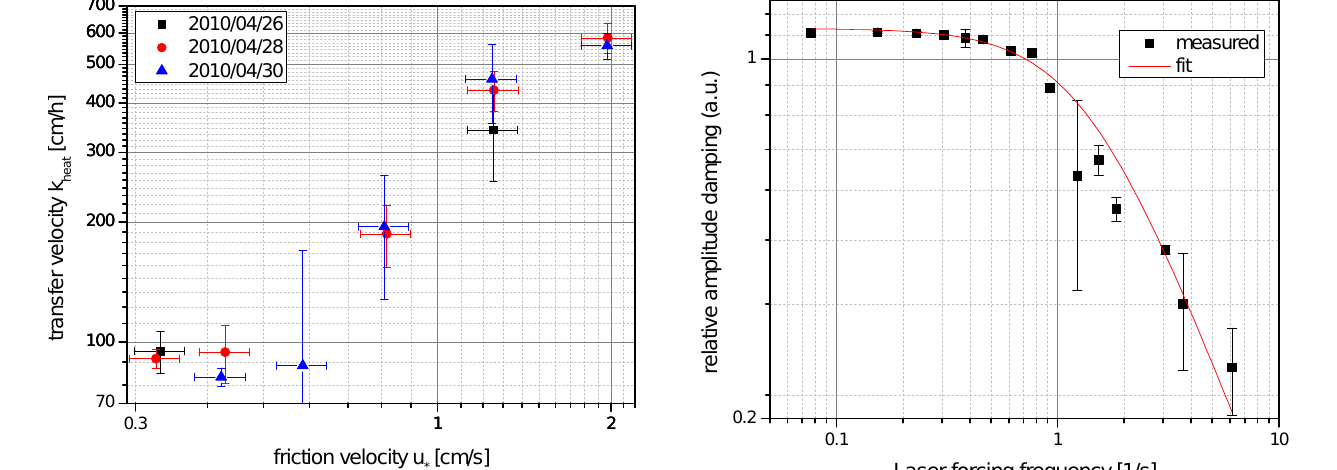
Figure 3. Example for measured amplitude damping plotted against the laser forcing frequency at a friction velocity of u ∗ = 0 . 28cms − 1 . At low forcing frequencies the thermal equilibrium was easily reached.